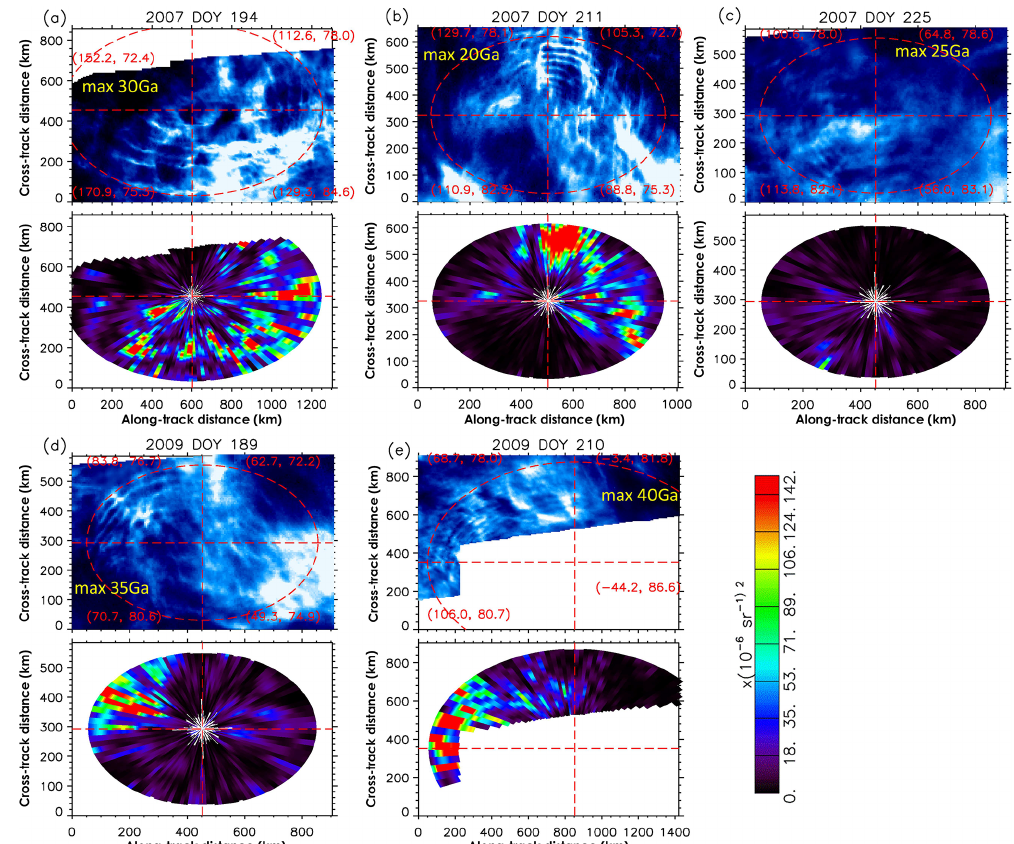
Figure 2. Wave tracking algorithm applied to the concentric waves (a) – (e) in the CIPS orbital strips. Wave tracking is carried out within the elliptical regions. For each pair, the upper panel is the albedo, and the lower panel is the albedo CWT wave power field by 3 ◦ angular bin × 5km radial bin. Blue–white color scheme is used for the albedo maps, with the white color representing the maximum albedo values indicated by the yellow legends, with 1Ga = 1.0 × 10 − 6 sr − 1 . The red numbers at the four corners are longitudes and latitudes. The rainbow color bar for the CWT power is used universally in this